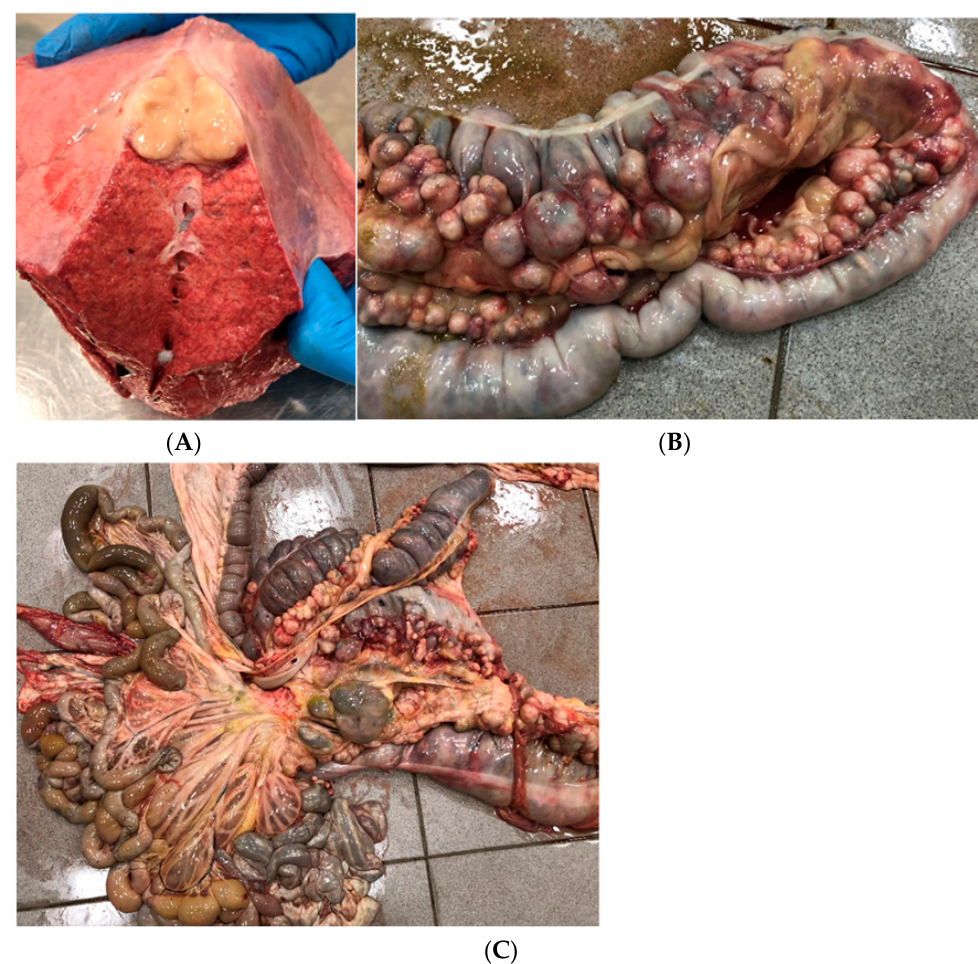
Figure 3. Anatomopathological findings concerning Case 2.1. Dissection of a pulmonary abscess ( A ), large intestine and mesenteric abscessation ( B , C ).